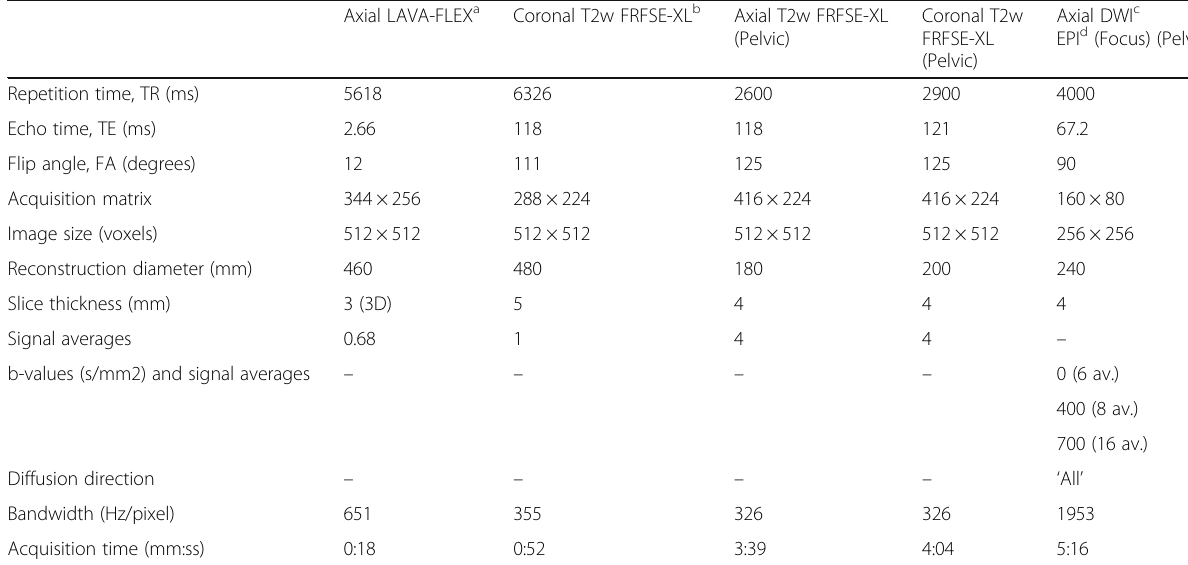
Table 1 MRI protocol parameters